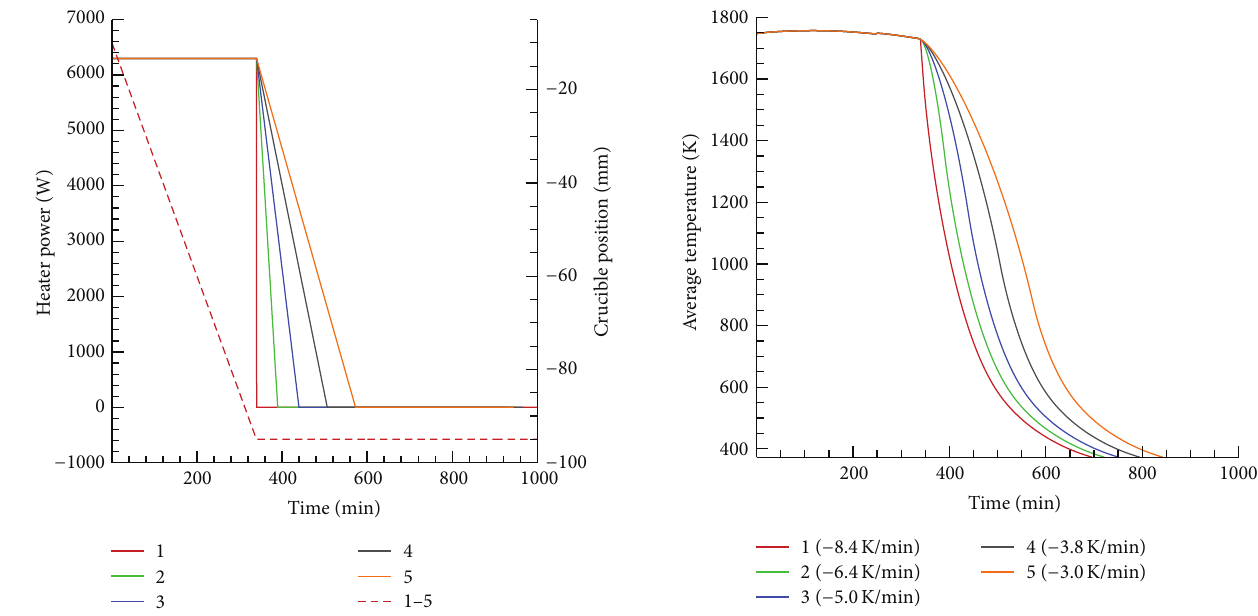
Figure 4: Average crystal temperature